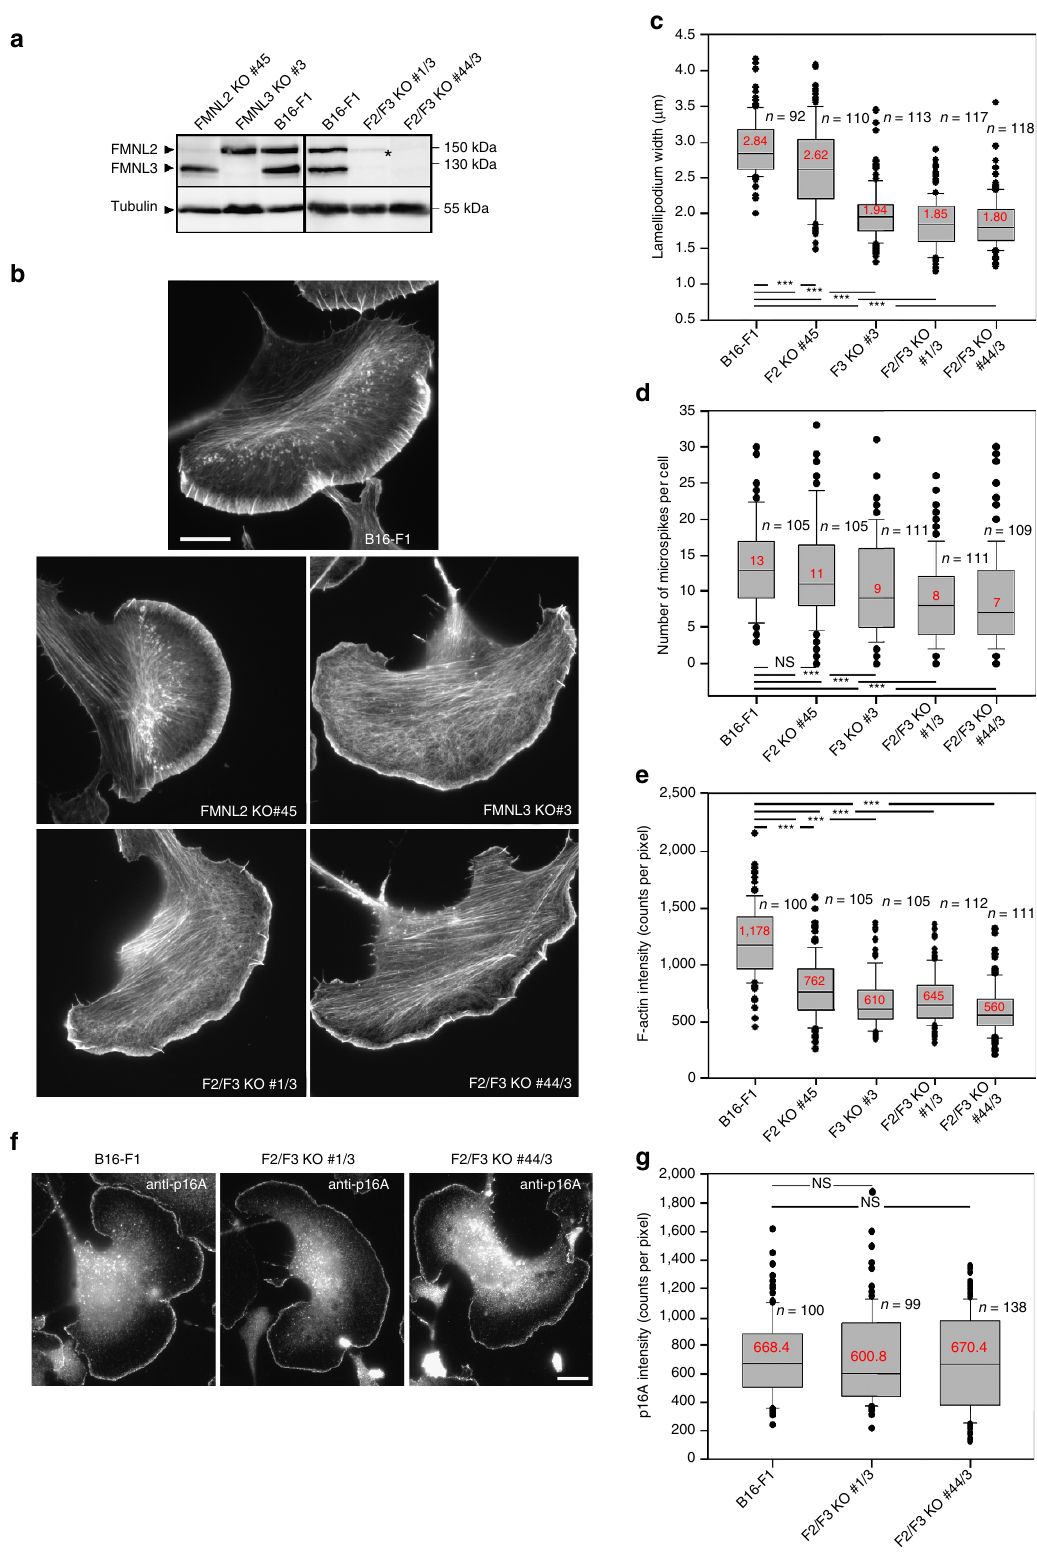
Figure 4 | Knockout of FMNL2/3 recapitulates RNAi phenotypes. ( a ) CRISPR/Cas9-mediated, specific loss of protein expression as documented by western blotting, using FMNL2/3-reactive antibody and tubulin as loading control. Asterisk marks non-specific band. ( b ) Representative cells stained for the actin cytoskeleton with phalloidin harbouring genotypes as indicated. Bar, 10 m m. ( c – e ) Box and whiskers plots summarizing the results from respective quantifications of lamellipodium width, microspike number per cell and F-actin intensity done in analogy to what is shown in Fig. 3. ( f ) Immunolabelling of the Arp2/3 complex subunit p16A (ARPC5A) in B16 cells and FMNL2/3 KO cells as indicated. Scale bar, 10 m m. ( g ) Quantification of Arp2/3 complex intensities in lamellipodia of wild-type and FMNL2/3 KO cells. *** p o 0.001 by Mann–Whitney rank sum